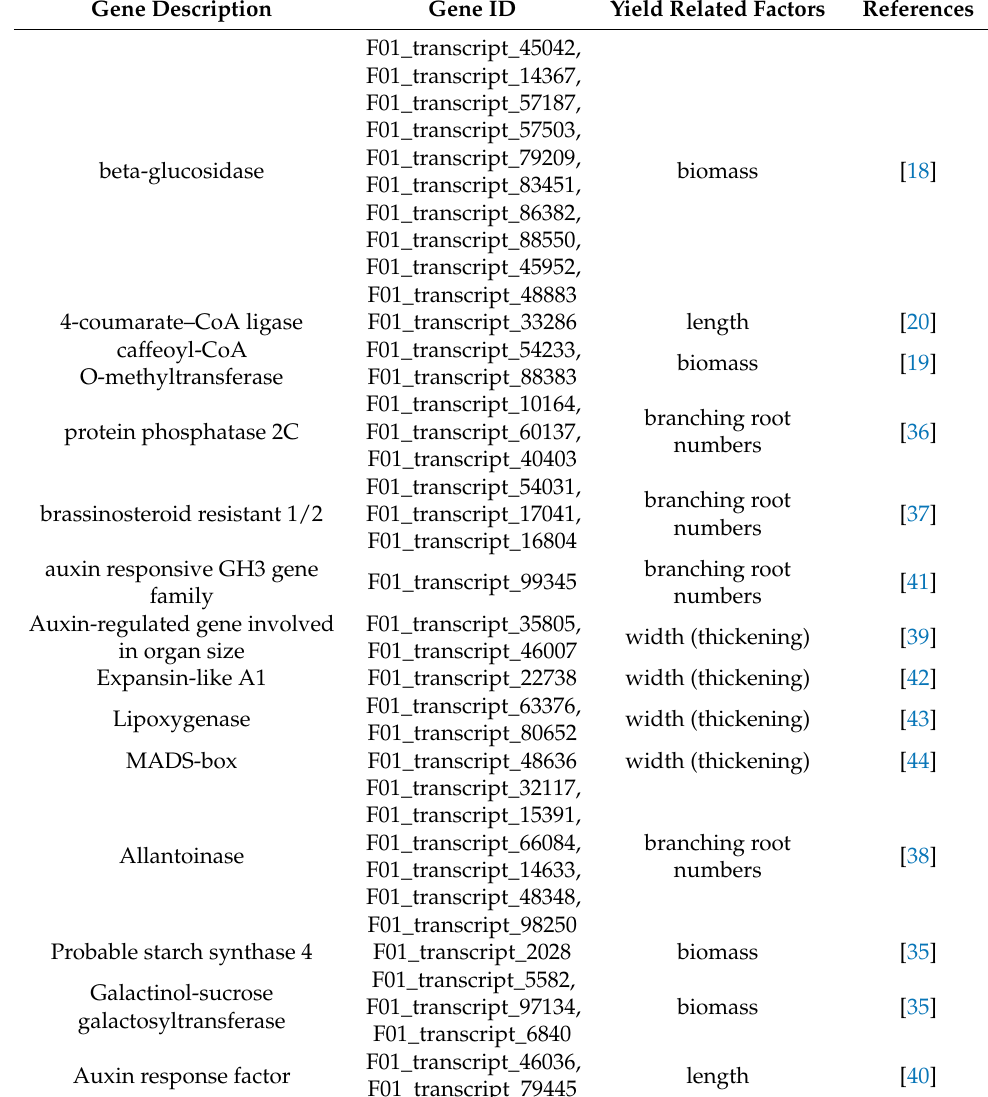
Table 4. Regulation of DEGs associated with yield on yield-related